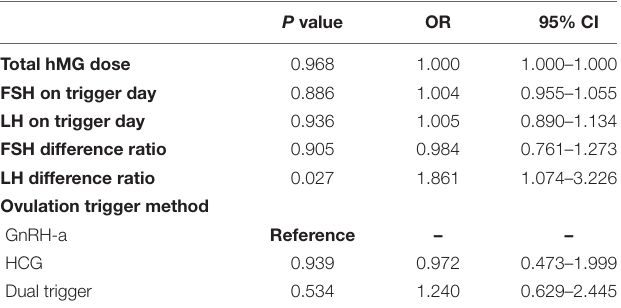
TABLE 2 | Factors influencing implantation success in the first frozen-thawed embryo transfer cycle by logistic regression analysis. P value